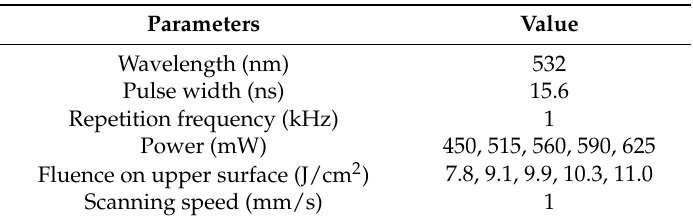
Table 1. Experimental laser